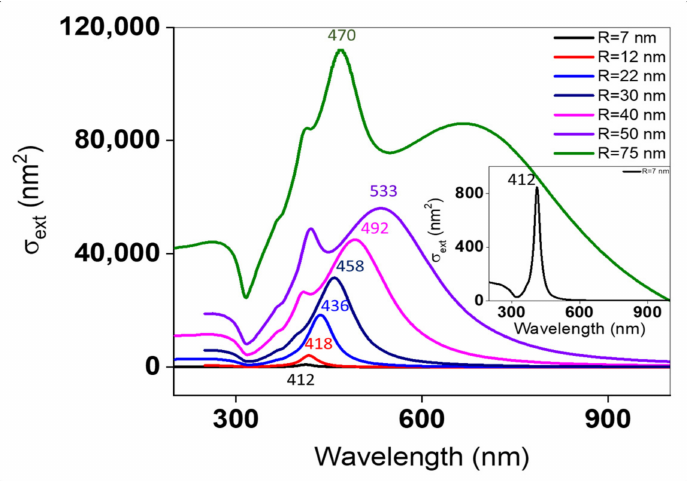
Figure 9. Mie theory calculations for the extinction cross-sections of different sizes of AgNPs suspended in a highly porous